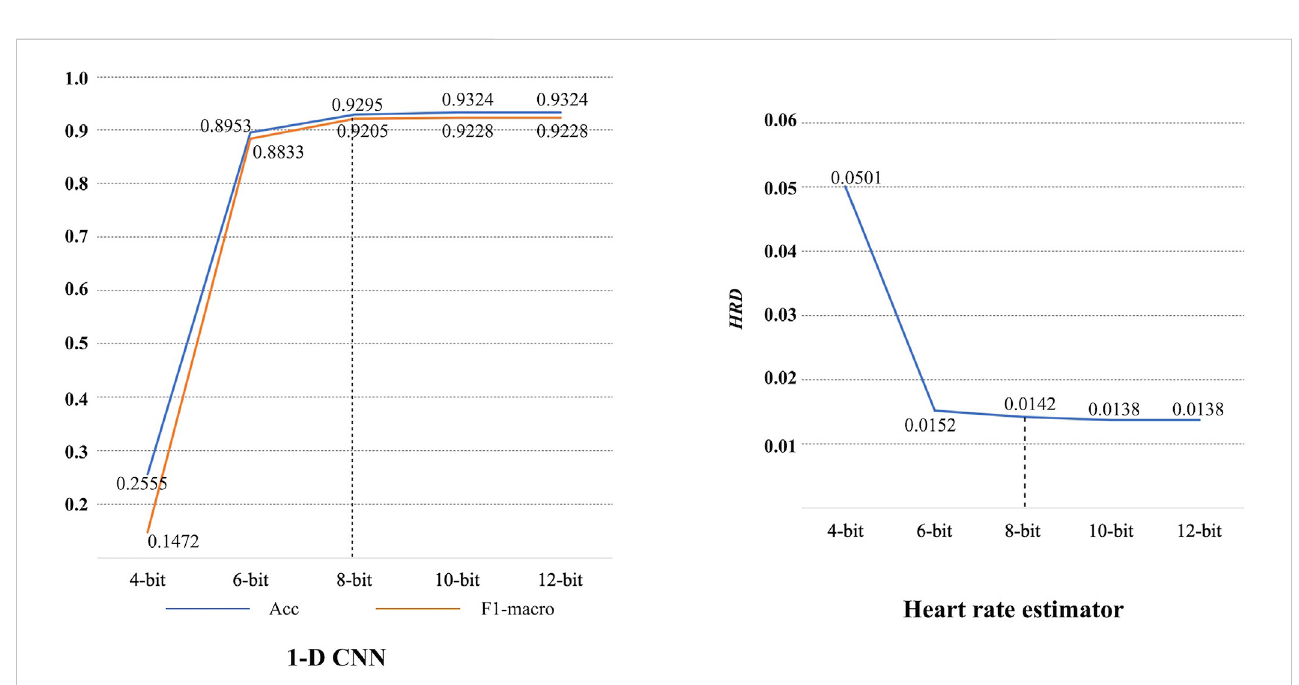
FIGURE 9 Performance degradation caused by